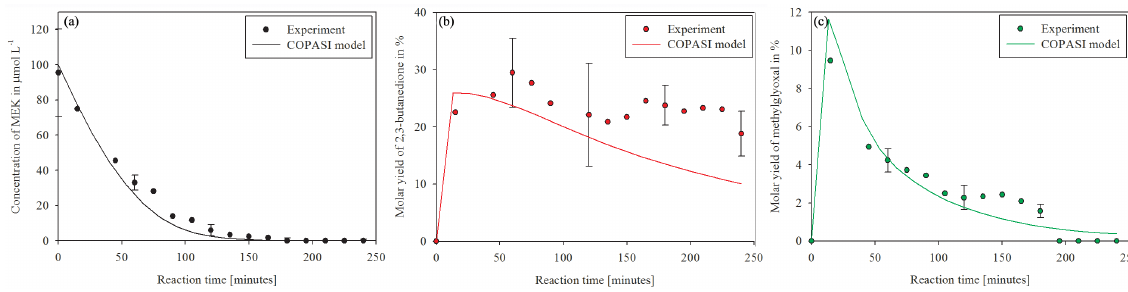
Figure 7. Comparison of the model and experimental results for MEK (a) , 2,3-butanedione (b) , and methylglyoxal (c)